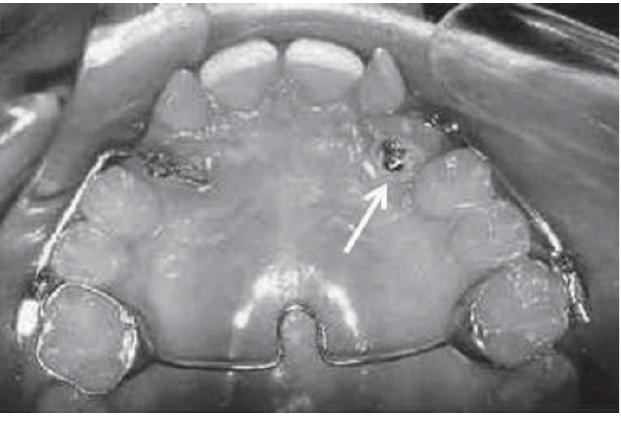
Fig. 11: Canine (left side) after open-eruption